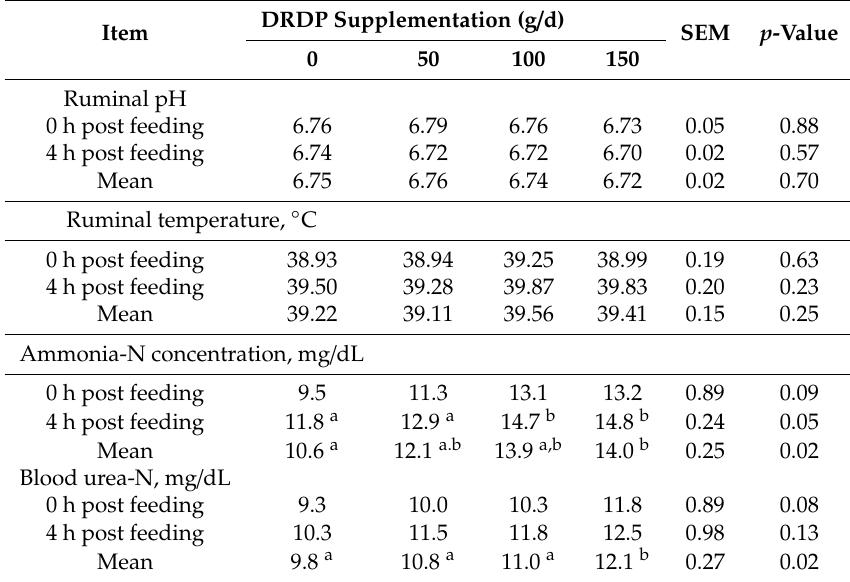
Table 3. E ff ect of dried rumen digesta pellets (DRDP) on rumen fermentation in Thai native, Wagyu-crossbred beef